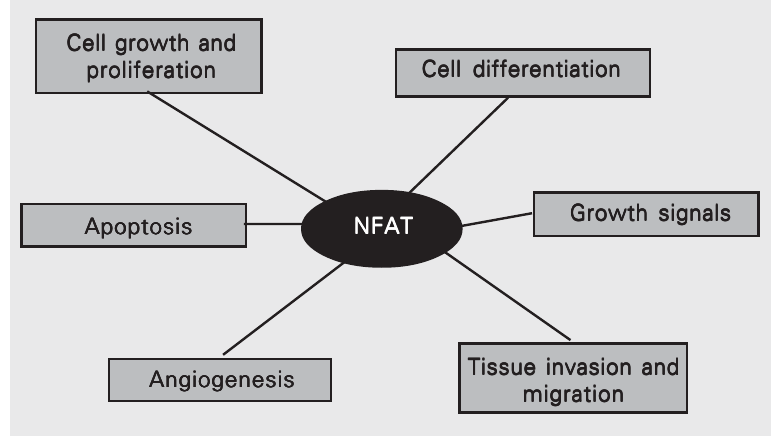
Figure 2. Tumor-related processes regulated by NFAT transcription factors. NFAT proteins have shown to directly regulate the expression of genes related to cellular proliferation (e.g., CDK4) and differentiation (e.g., cytokines and growth factors), apoptosis (e.g., FasL), angiogenesis (e.g., cyclooxygenase-2) and tissue invasion mechanisms among others. NFAT = nuclear factor of activated T